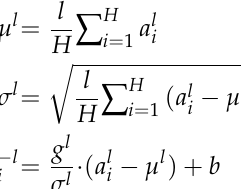
Figure 4. The structure of the multi-head attention. In layer normalization, the input of neurons in the same layer has the same mean and variance, and different input samples have different mean and variance. Compared with batch normalization, it is necessary to calculate and save the mean and variance of a certain layer of neural network batch. Statistical information is more suitable for time series models with depth changes. Batch normalization is shown in Equation (6).